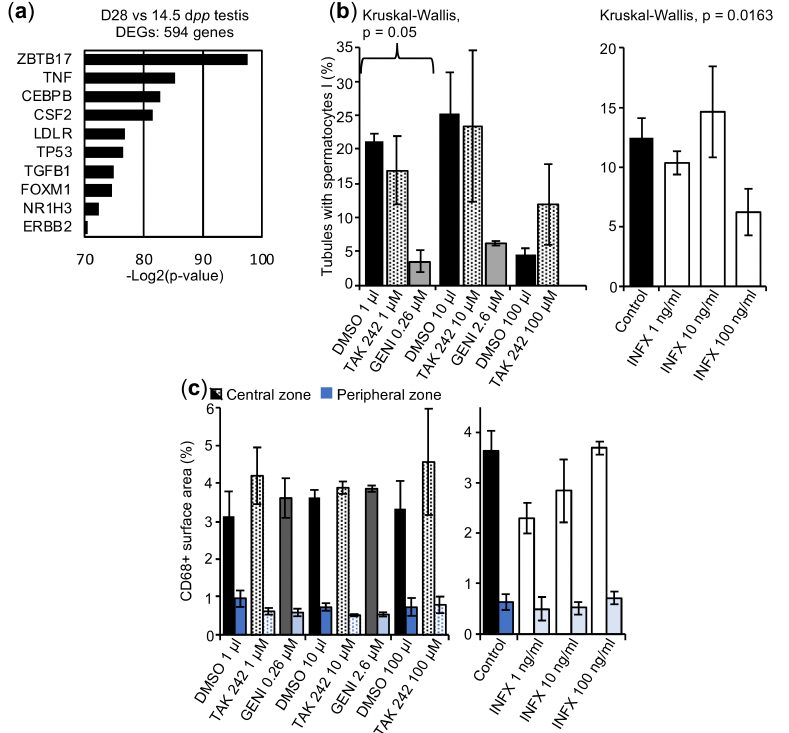
Figure 7. Analysis of in vitro cultures supplemented with anti-inflammatory molecules. ( a ) Pre- dicted upstream transcriptional regulators of 594 DEGs between D28 in vitro cultured tissues and 14.5 dpp in vivo controls. ( b ) Percentage of seminiferous tubules at the spermatocyte I stage after 28-day cultures with anti-inflammatory molecules. ( c ) Percentage of surface area occupied by CD68+ macrophages. Left and right bars refer to the percentage of CD68+ surface area within the central and peripheral zones of the testicular fragments, respectively. n = 3. For statistical analyses, Kruskal– Wallis tests followed with Dunn’s post-test were applied. Tissues cultured with TAK 242 or Genistein (GENI) were compared to tissues cultured with DMSO. Tissues cultured with Infliximab (INFX) were compared to tissues cultured without DMSO. Data are expressed as mean ±